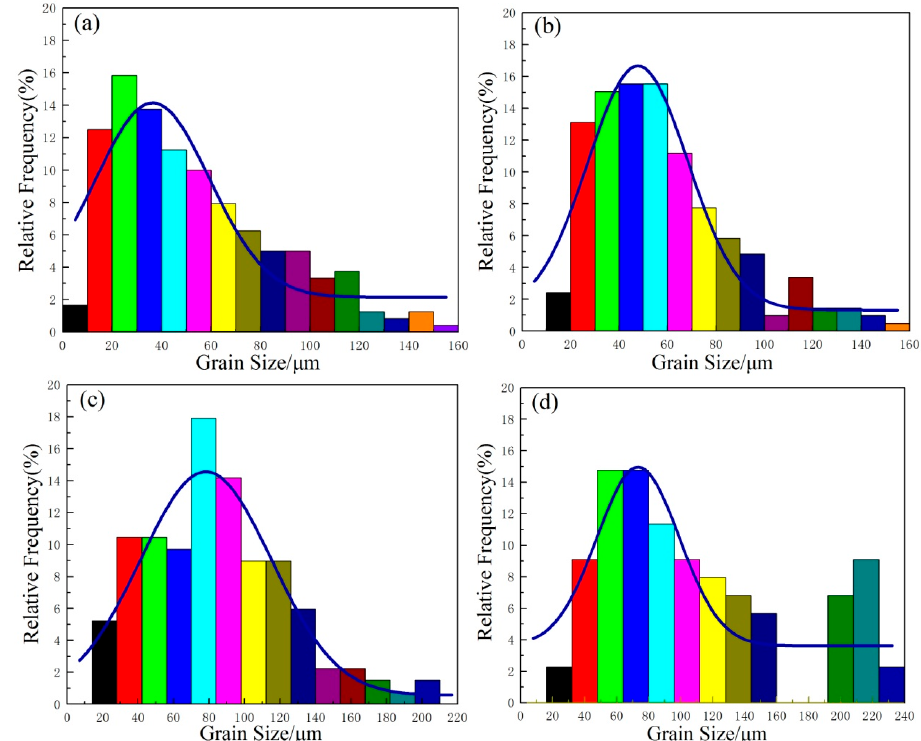
Figure 9. Grain ‐ size distribution histograms obtained upon solution treatment at ( a ) 1170 °C for 0.5 h; Figure 9. Grain-size distribution histograms obtained upon solution treatment at ( a ) 1170 ◦ C for 0.5 h; ( b ) 1170 °C for 2 h; ( c ) 1200 °C for 2 h; and ( d ) 1230 °C for 3 h. ( b ) 1170 ◦ C for 2 h; ( c ) 1200 ◦ C for 2 h; and ( d ) 1230 ◦ C for 3